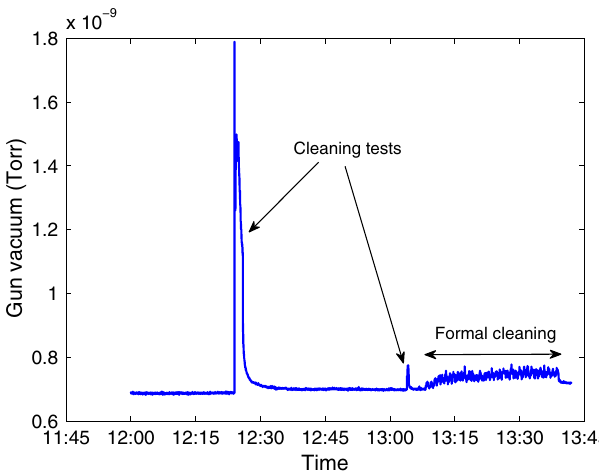
FIG. 2. Typical ‘‘vacuum activity’’ in the rf gun waveguide during the laser-cleaning process: about 0 : 5 (cid:1) 10 (cid:2) 10 Torr of the pressure rise in the gun waveguide (blue) is observed during the laser-cleaning process.